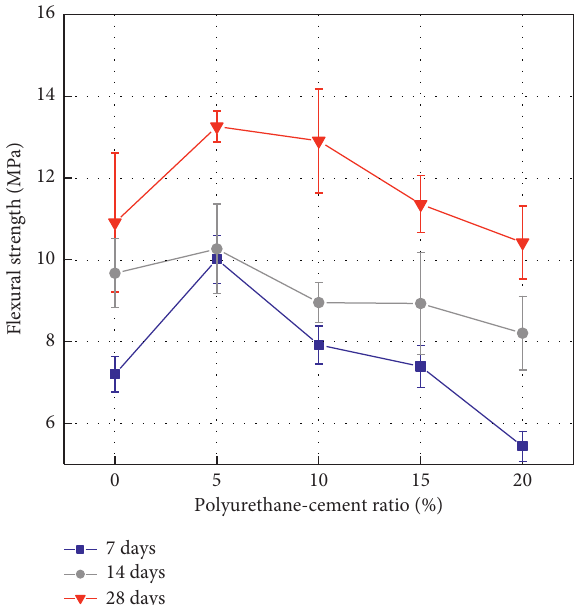
Figure 8: Variations of flexural strength of PFCBCM versus mass content of